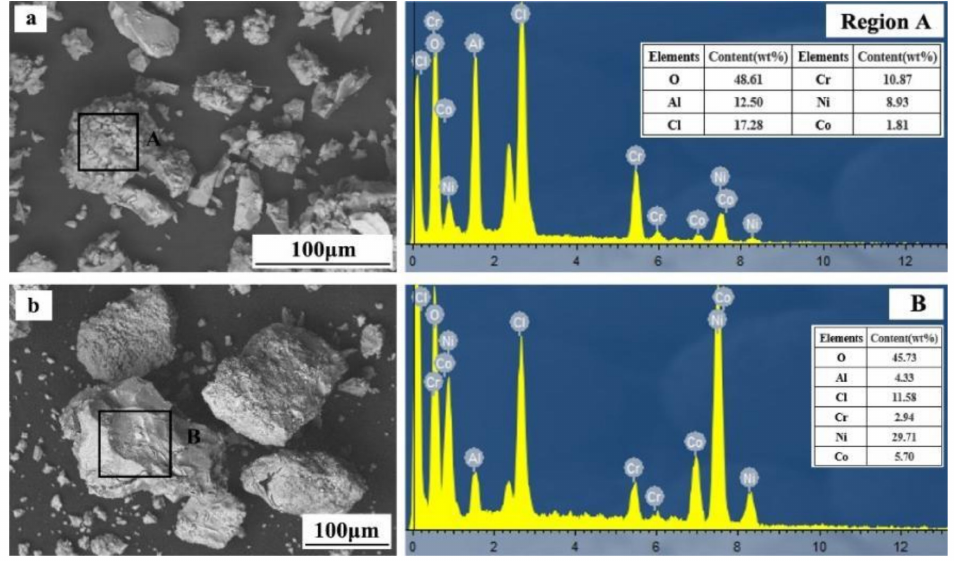
Figure 10. SEM and EDS analyses of products with different pH values (( a )—pH of 4; ( b )—pH of